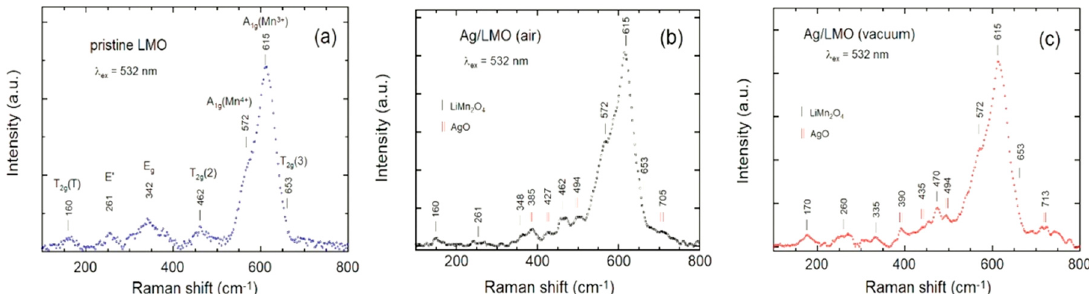
Figure 8. Raman spectra of samples recorded with the laser excitation line at 532 nm (green light): ( a ) pristine LMO; ( b ) Ag/LMO(a); and ( c ) Ag/LMO(v).